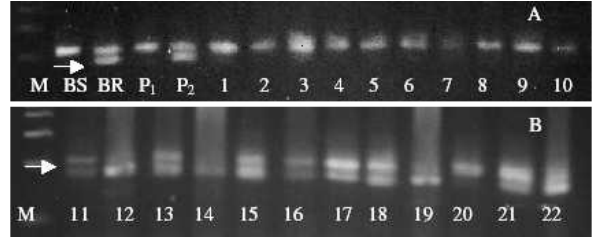
Figure 1 - DNA band pattern amplified by the primer SSR PV-atct 001. BR is the resistance bulk. BS is the susceptible bulk. P 2 is the ‘ESAL 550’ resistant parent. P 1 is the ‘Carioca MG’; In A. from 1-10 are the suscepti- ble F 2:3 families; In B. from 11-22 are the resistant F 2:3 families; M is the 100 pb Promega DNA ladder. The arrow indicates the polymorphic band of 282bp.